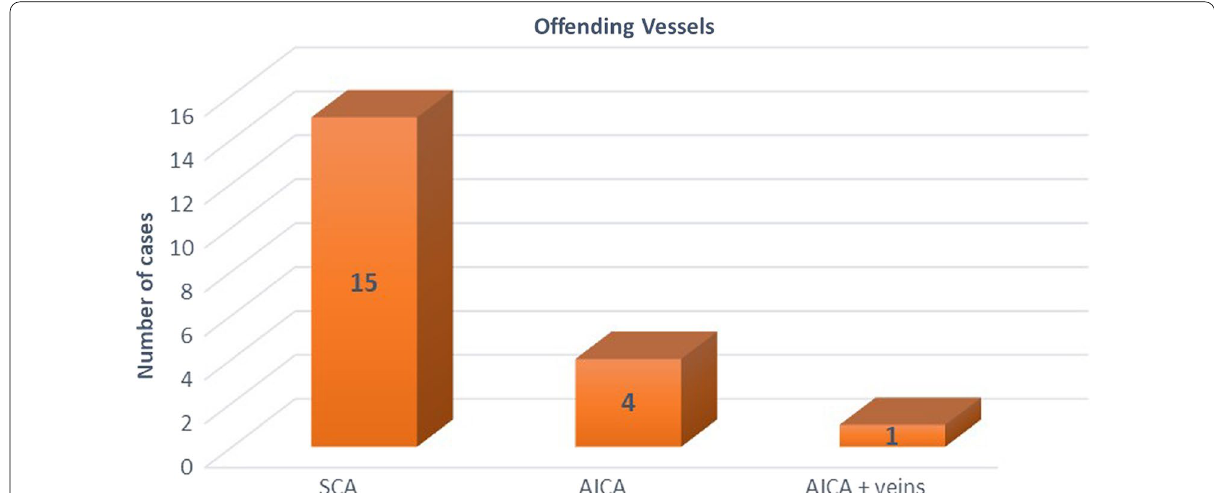
Fig. 4 The intraoperative findings of the different neuro-vascular conflict types